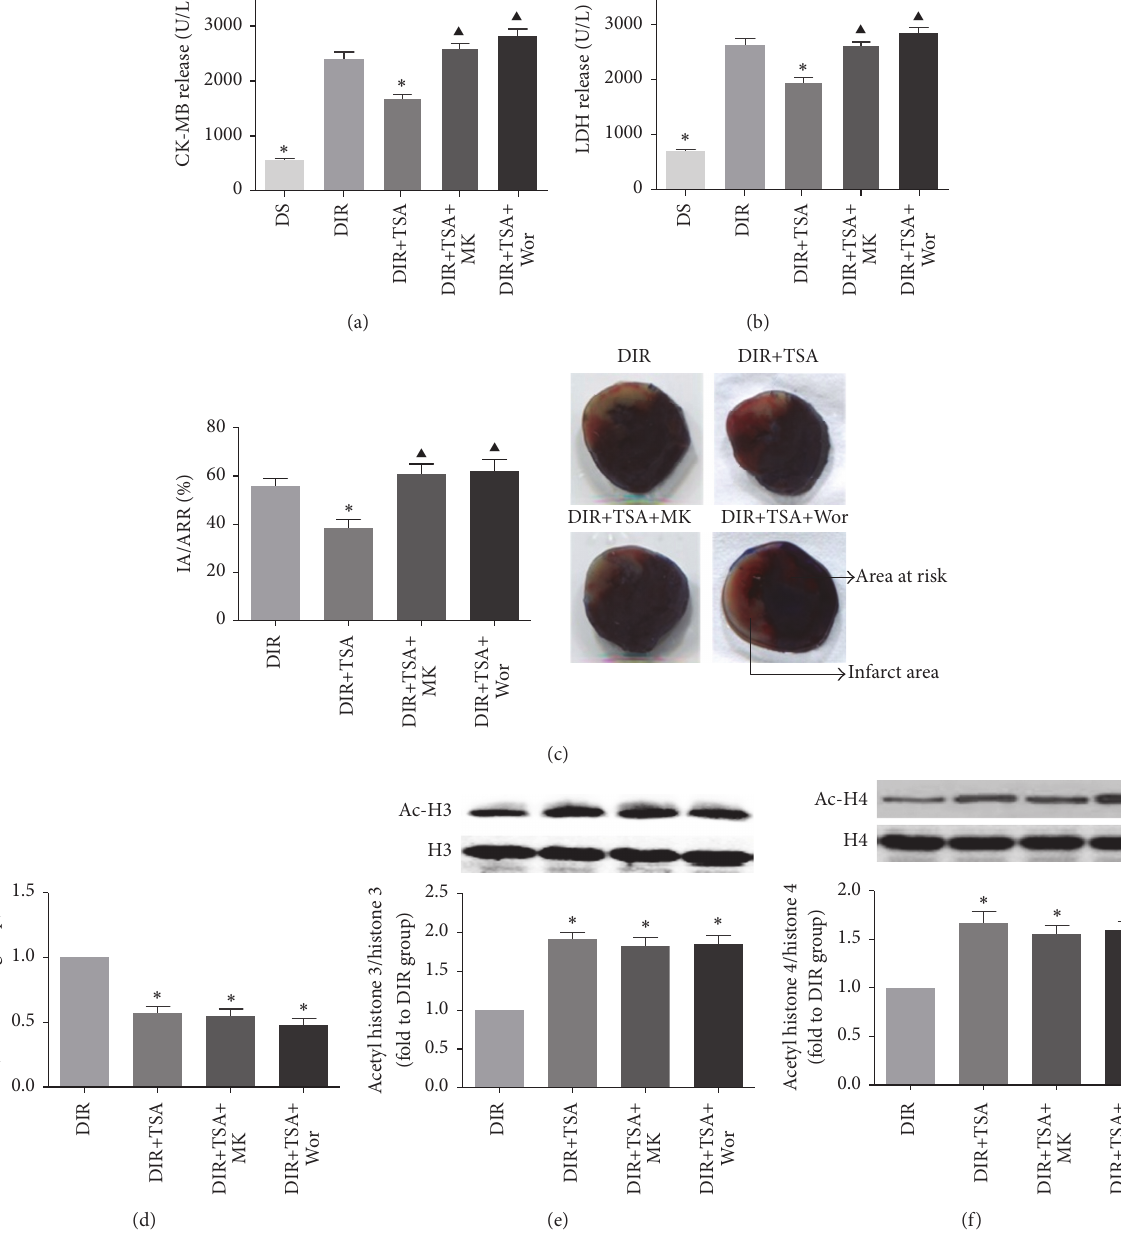
Figure 3: The HDAC inhibitor attenuated MI/R injury in diabetic hearts. Serum levels of myocardial injury marker CK-MB (a) and LDH (b). (a) Infarct area versus area at risk (IA/AAR × 100%). Blue-stained areas represent the nonischemic part; red-stained areas represent the area at risk and pale areas indicate myocardial infarction. Area at risk and infarct area were pointed out by arrows. HDACs activity (d) and acetylated level of histone 3 (e) and histone 4 (f). All the results are presented as mean ± SEM, 𝑛 = 6 /group. ∗ 𝑝 < 0.05 versus DIR group. 󳵳 𝑝 < 0.05 versus DIR+TSA group. Table 1: Effects of TSA on LV hemodynamic parameters after